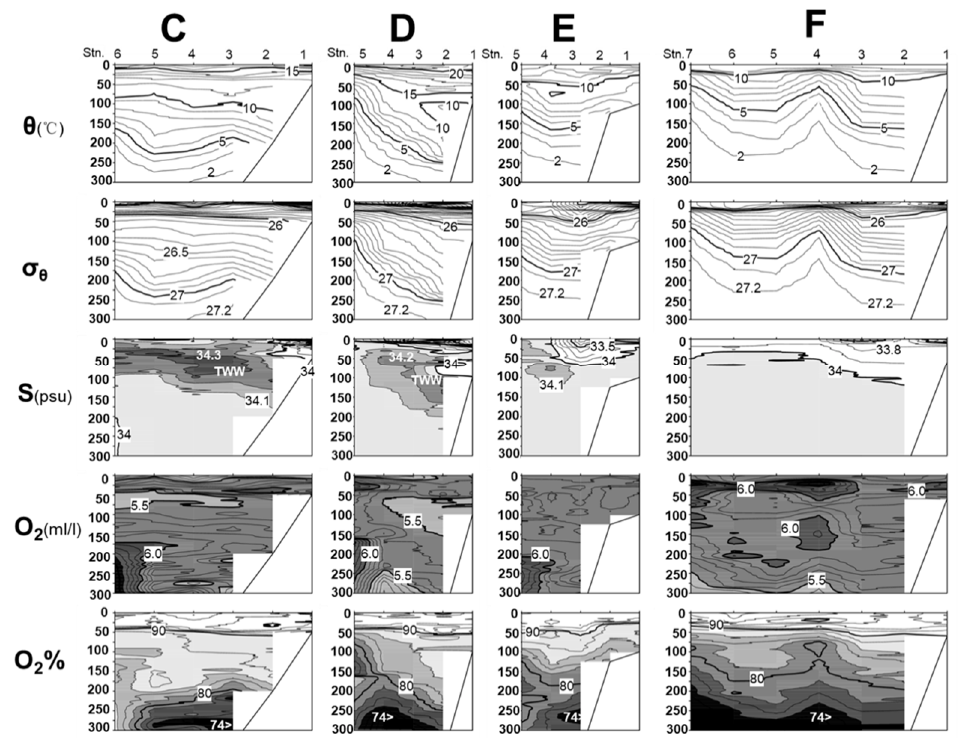
θ , σ θ , S, O 2 and O 2 % along lines C to F in June